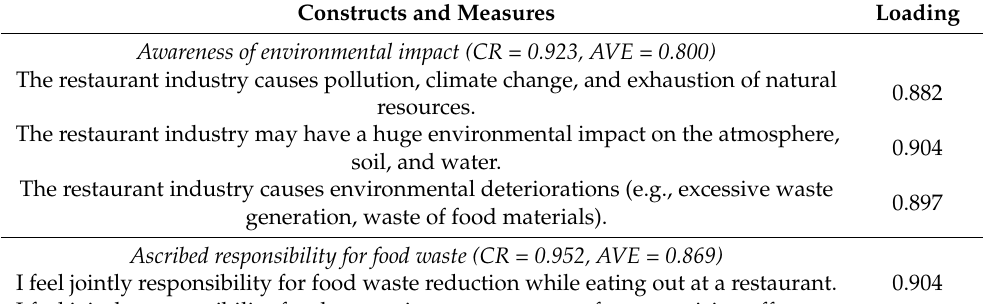
Table 1. Measurement model